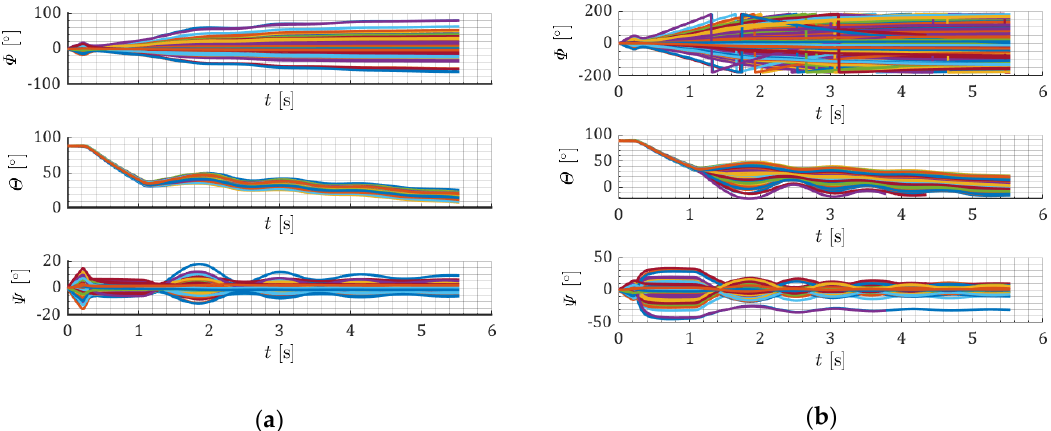
Figure 13. Projectile roll, pitch and yaw angles for various initial roll rate standard deviations. (a) 10°/s; (b) 60°/s.